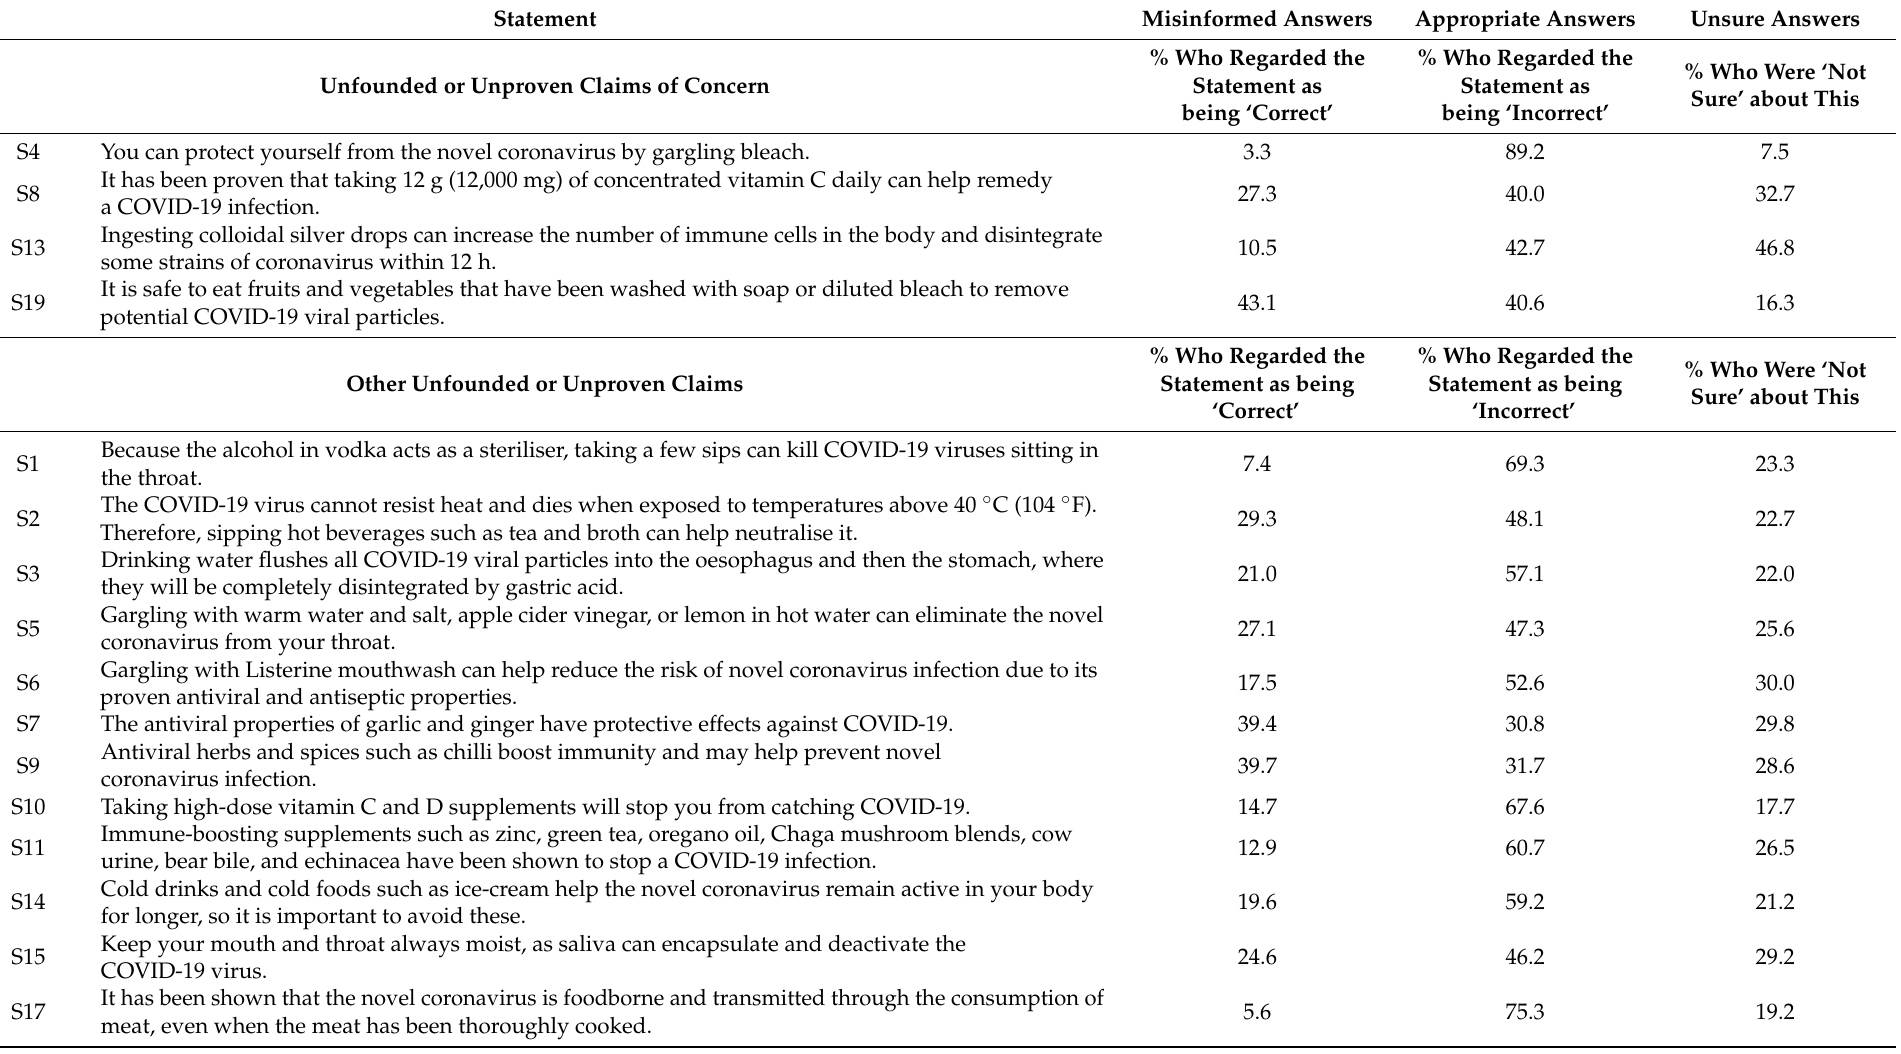
Table 1. Percentage of participants who gave misinformed